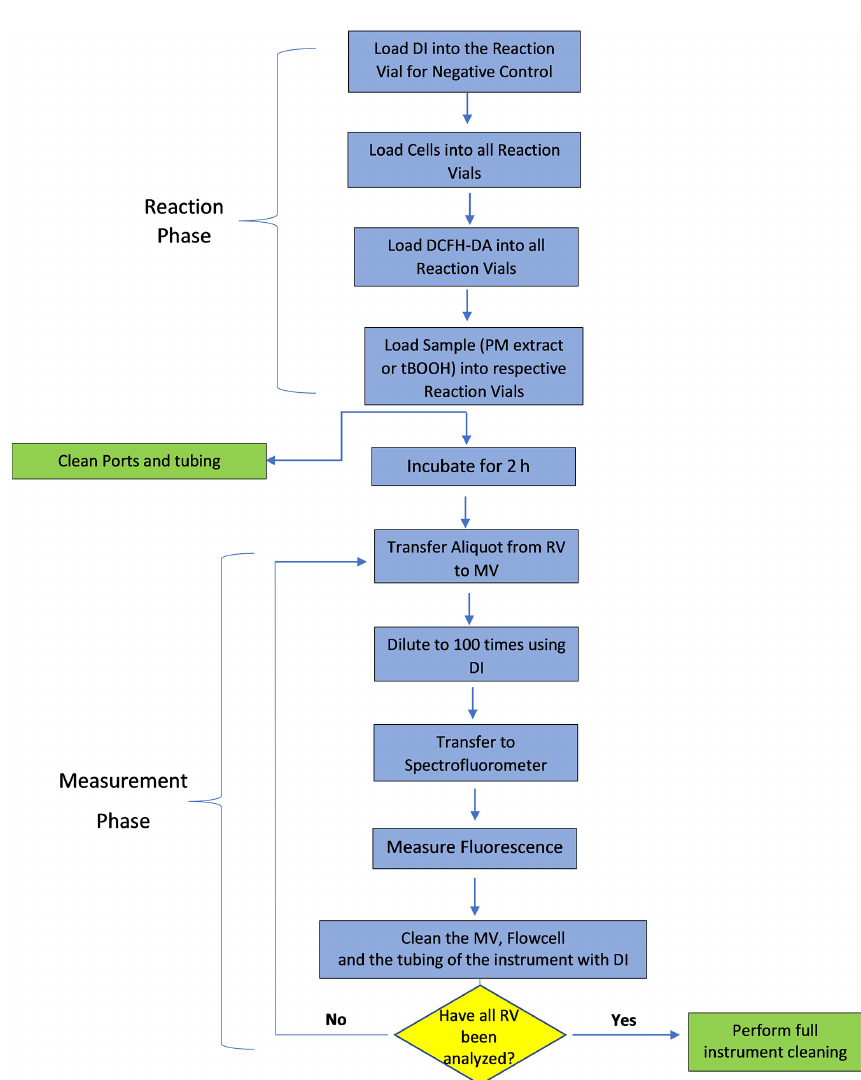
Figure 2. Algorithm for the instrument’s operational